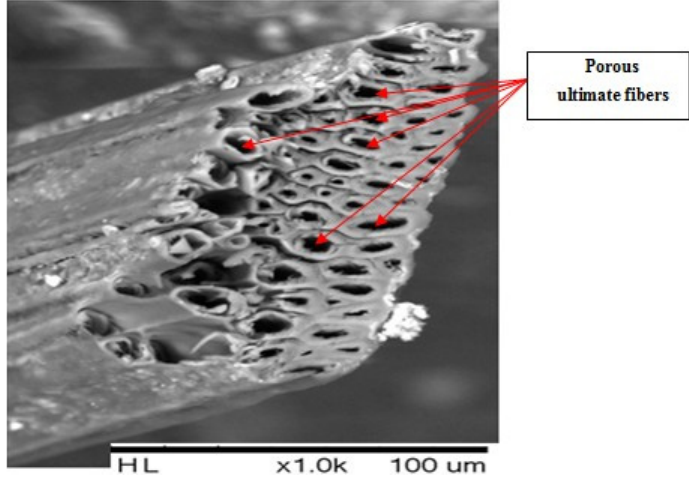
Figure 8. Cross-sectional view of a raw Posidonia technical fiber.